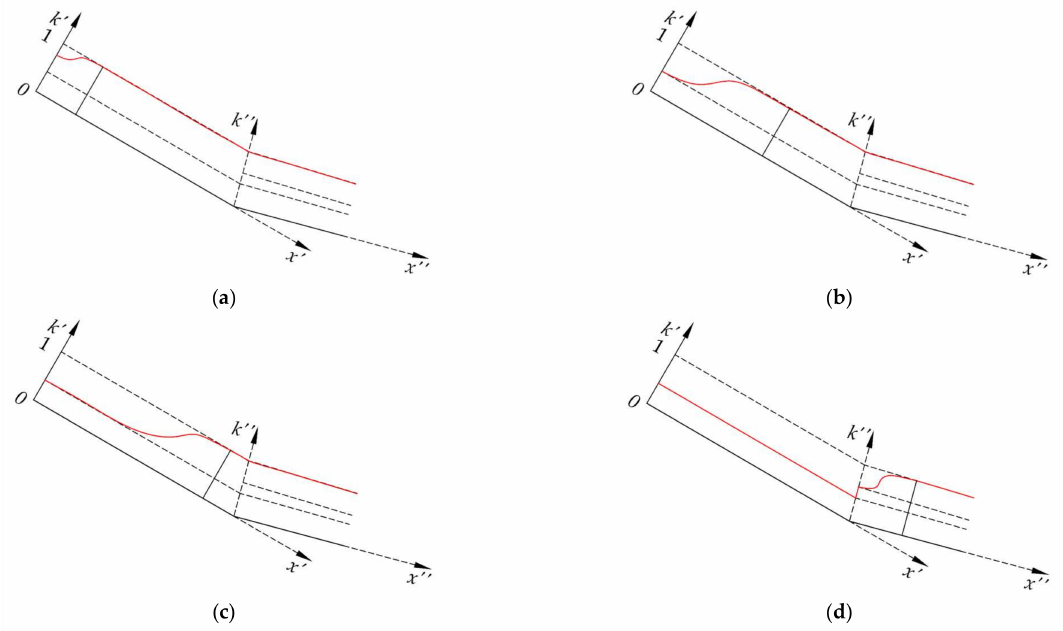
Figure 7. Schematic diagram of the “S”-shaped curve of each stage of the weakening of sliding zone soil of thrust-load- induced accumulation landslides triggered by rainfall infiltration: ( a ) the sliding zone begins to weaken locally from the trailing edge; ( b ) a complete “S”-shaped curve is formed; ( c ) the “S”-shaped curve gradually advances towards the front edge; ( d ) it approaches the sliding